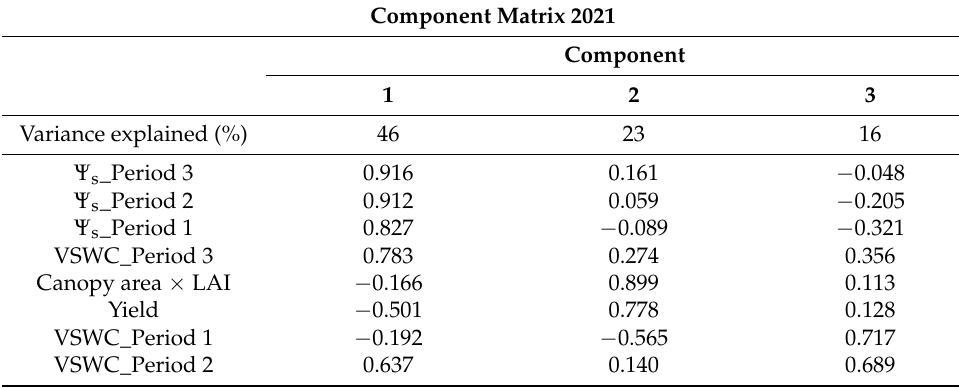
Table A3. Principal component matrix for different variables (sorted by size) and variance explained by each principal component for